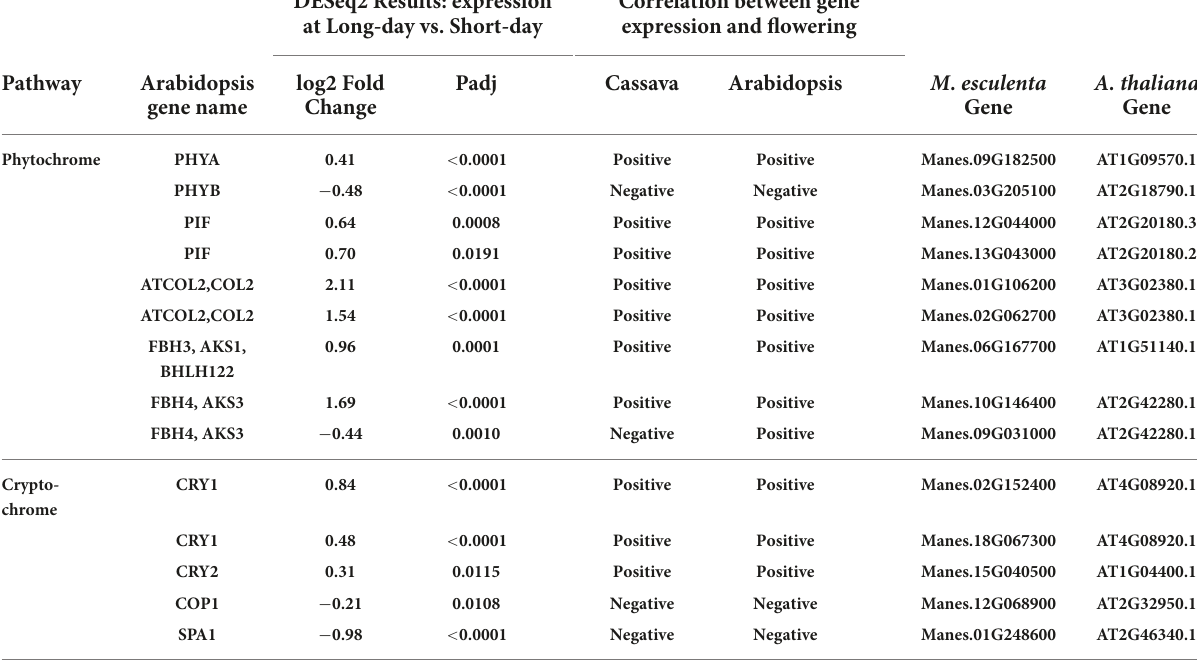
TABLE 4 Significant differentially expressed genes (DEGs) and log2 Fold Change from flowering pathways showing the most similarity to flower regulation in A thaliana and relevant down stream genes part of the phytochrome and cryptochrome light signaling pathways. DESeq2 Results: expression Correlation between gene at Long-day vs. Short-day expression and flowering